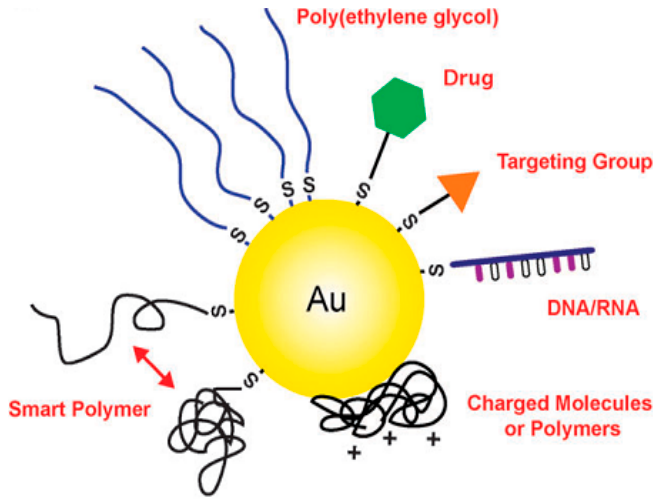
Figure 3. Gold nanostructures can be conjugated with a wide variety of functional moieties, both through the gold–thiolate bond and by passive adsorption. Reprinted with permission from Chemical Society Reviews, 2011, 40, 44–56. Copyright (2011) American Chemical Society.